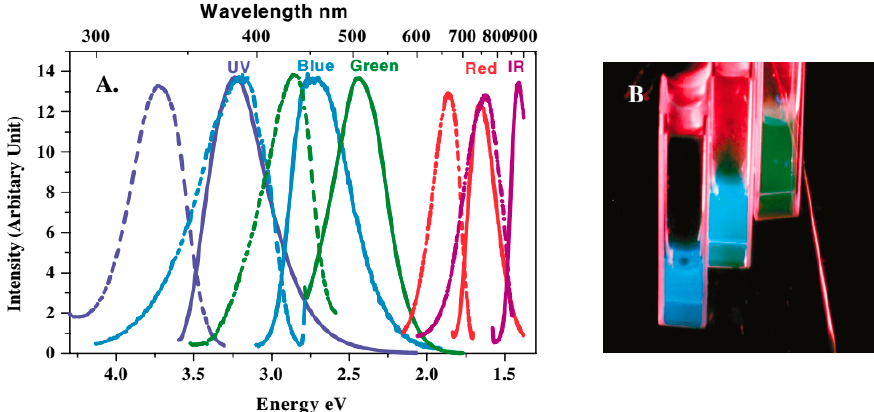
Figure 1. ( A ) Excitation (dashed) and emission (solid) spectra of polyamidoamine (PAMAM)-protected gold nanoclusters (AuNCs) with varied sizes. ( B ) Emission from the three shortest wavelength emitting AuNCs solutions (from left to right) under UV irradiation. Adapted with permission from Reference [34] Copyright (2004) American Physical Society Sites.